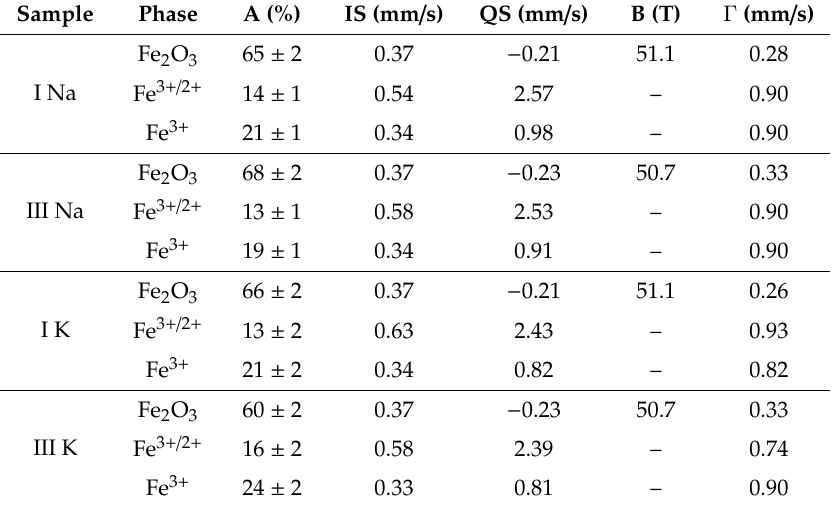
Table 3. The results of Mössbauer spectroscopy